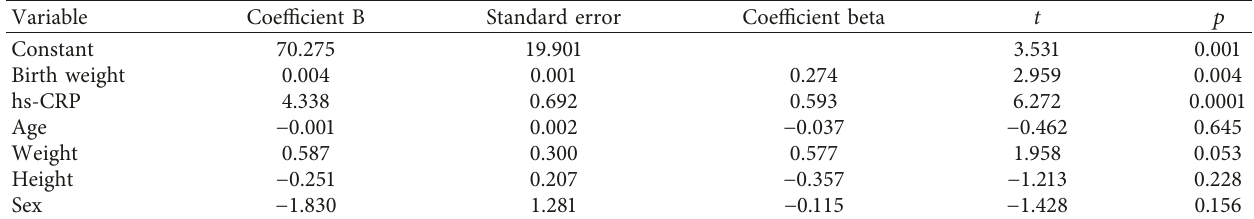
Table 7: Relationship of hs-CRP and birth weight with diastolic blood pressure with control variables such as child’s age, sex, weight, and